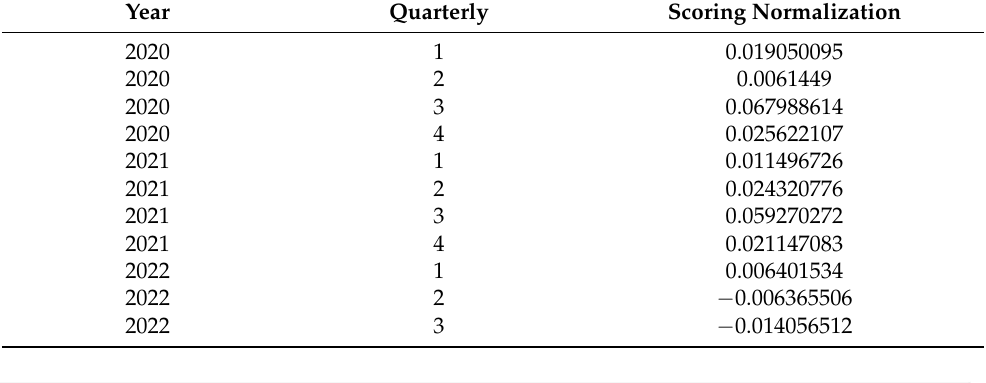
Table 20. Normalized sentiment score.